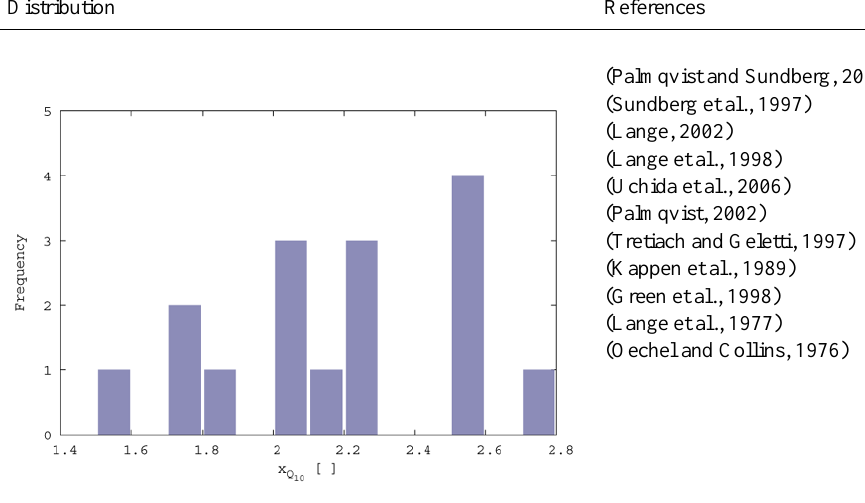
Fig. B7. Overview of the distribution of the Q 10 value of respiration x Q